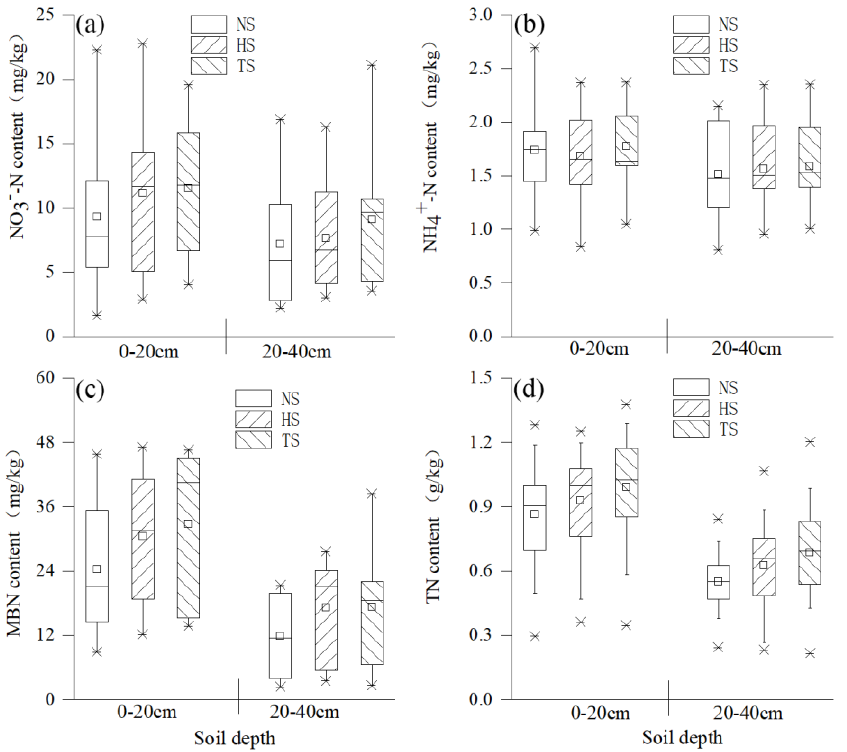
Figure 2. Effect of different straw applications on mean content of soil nitrogen components. ( a ), NO 3 − -N content, NO 3 − -N, nitrate-N; ( b ), NH 4+ -N content, NH 4+ -N, ammonium-N; ( c ), MBN content, MBN, microbial biomass nitrogen; ( d ), TN content, TN, Soil total nitrogen;.